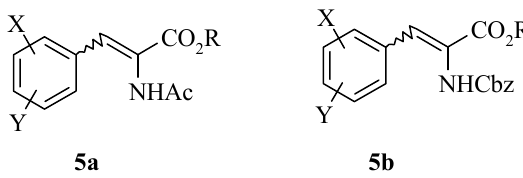
Figure 2. Dehydrophenylalanine